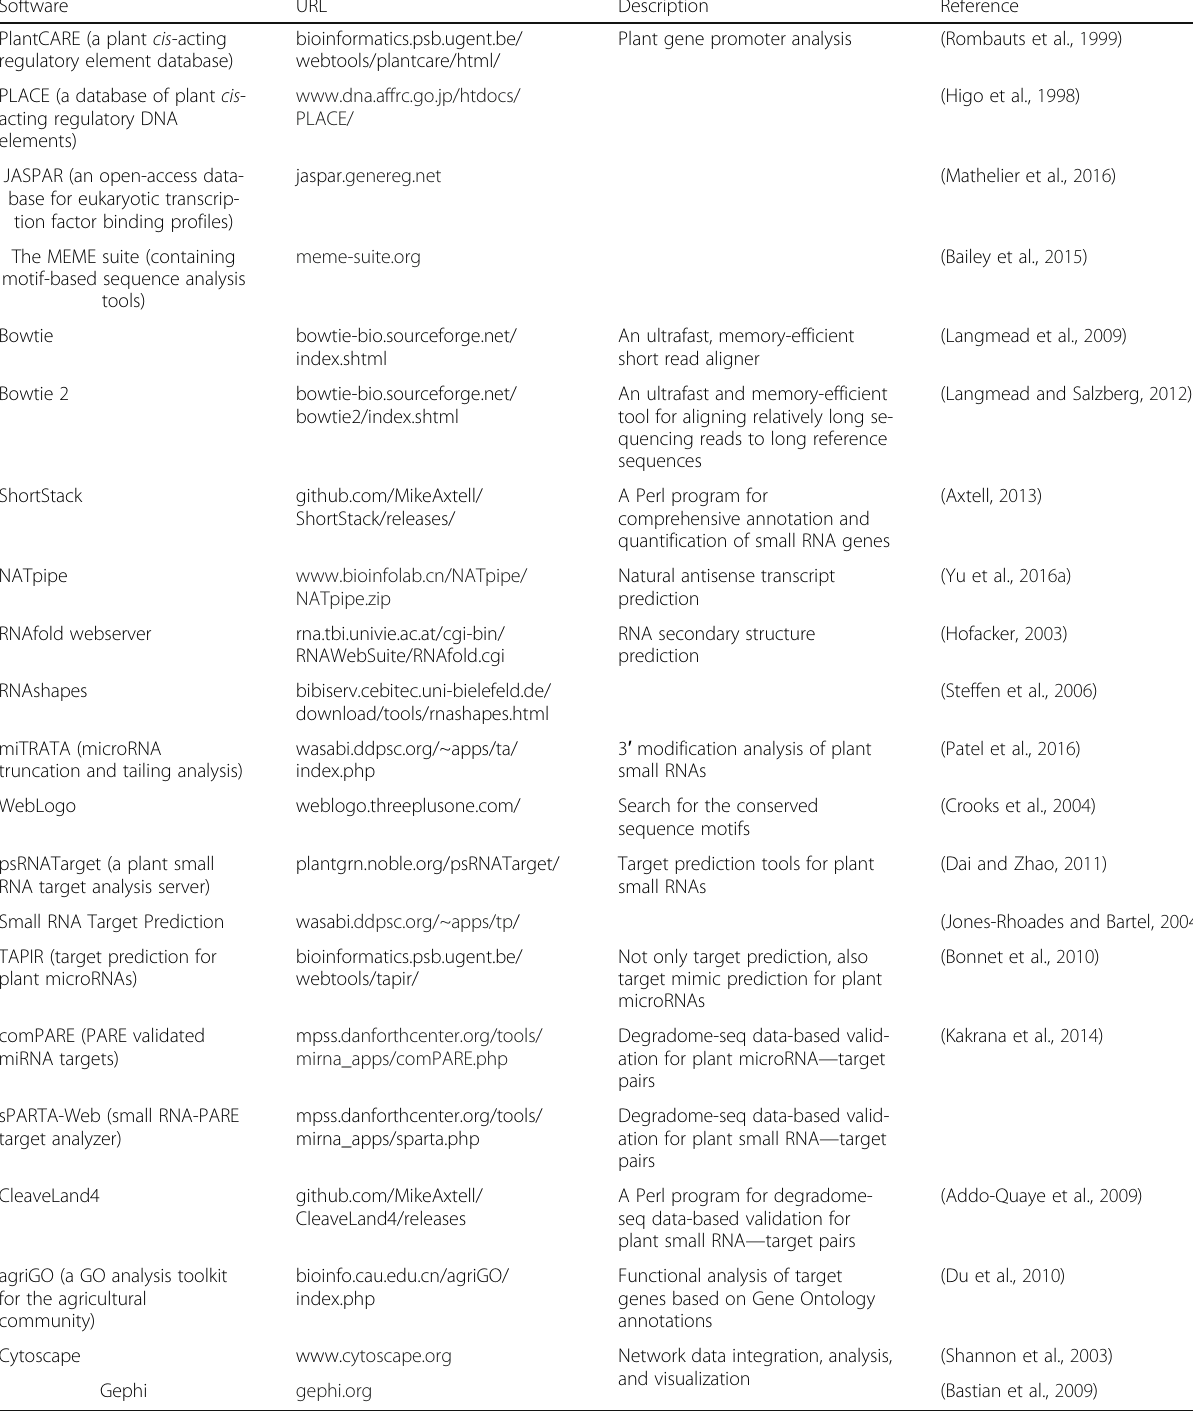
Table 2 List of softwares for plant small RNA research